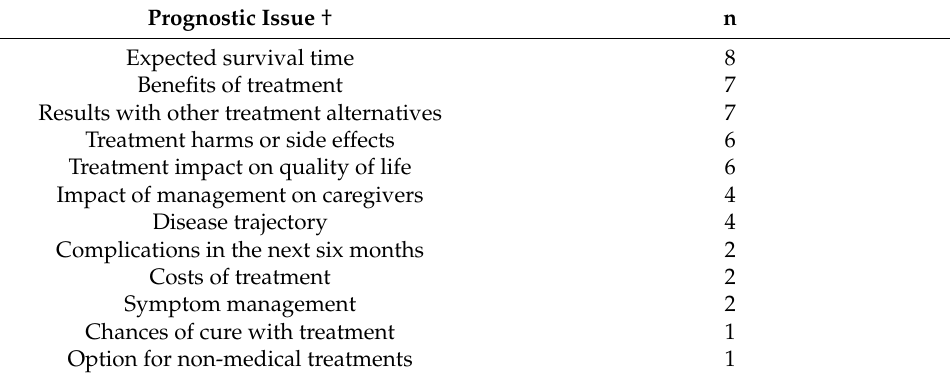
Table 2. Type of prognostic news respondents are interested in learning from their health ser- vice provider.